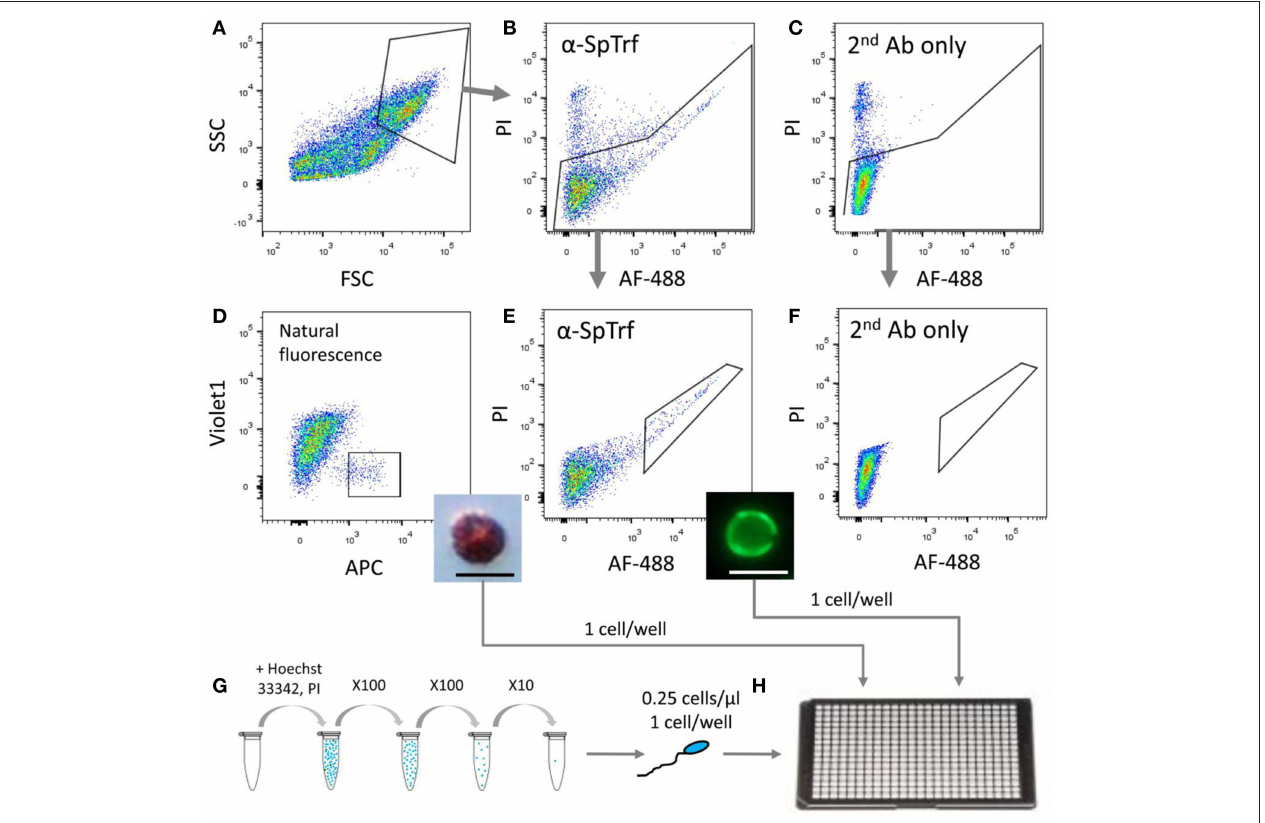
FIGURE 4 | Sorting and isolation of single cells from two coelomocyte sub-populations and from sperm for WGA. Small phagocytes that express SpTrf on their surface and red spherule cells were sorted from animals 1–3 pre-challenge on day 0 as well as on days 1 and 2 post-challenge with Vibrio diazotrophicus . Sperm cells were collected directly from the gonopores of the same sea urchins. (A) Coelomocytes were gated from debris based on forward scatter (FSC) and side scatter (SSC). (B) Live cells were gated for propidium iodide (PI) exclusion and for surface staining of anti-SpTrf and secondary antibody conjugated with Alexa Fluor 488 (AF-488). (C) Live cells incubated with the secondary antibody alone did not show AF-488 staining. (D) Red spherule cells were gated based on their natural far-red auto-fluorescence (allophycocyanin channel; APC). Single cells with high auto-fluorescence were sorted and observed post-sorting by light microscopy (inset). (E) Live cells with high surface SpTrf protein levels were gated based on the AF-488 fluorescence of the secondary antibody. Single cells were sorted and observed post-sorting by fluorescence microscopy (inset). (F) No cells were recorded in the same gate as in (E) for the sample incubated with the secondary antibody only. This demonstrated that all cells within the gate in (E) had SpTrf on the surface and were likely small phagocytes. (G) Sperm cells were obtained by electric shock stimulation (16–20mA), diluted to 1 × 10 5 cells/ml, stained with Hoechst 33342 and serially diluted to 0.25 cells/ µ l. (H) Single cells of each type were isolated either by FACs or manually into 4 µ l of 3.3X PBS in a 384-well plate, observed under epifluorescent microscope, and subjected to WGA using the multiple displacement amplification with the REPLI-g single-cell kit (Qiagen). The scale bars in the insert figures in (D , E) are 10 µ